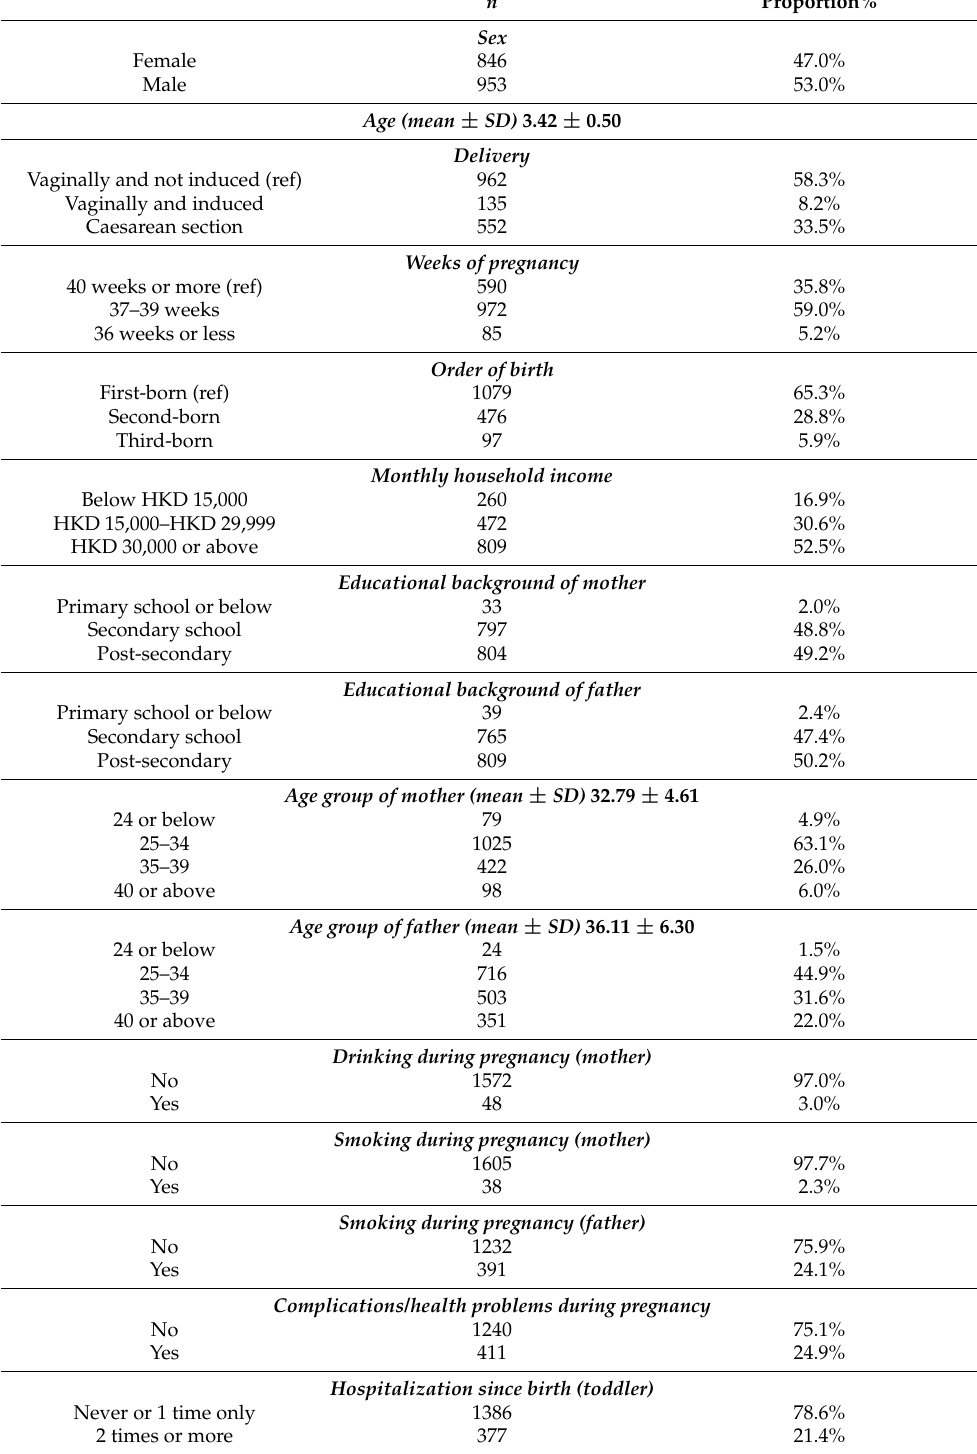
Table 1. Characteristics of participants in the